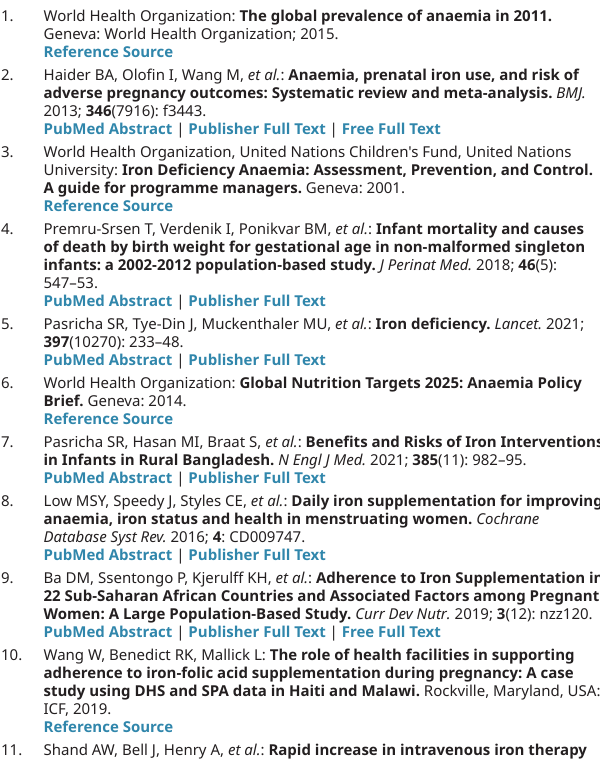
protocol 13 and documents version 1 dated October 26,